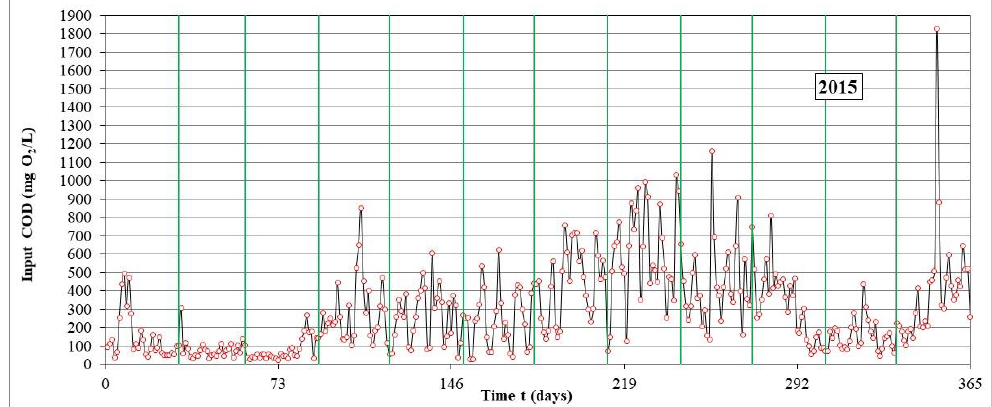
Figure 2. Input of COD for year 2015.